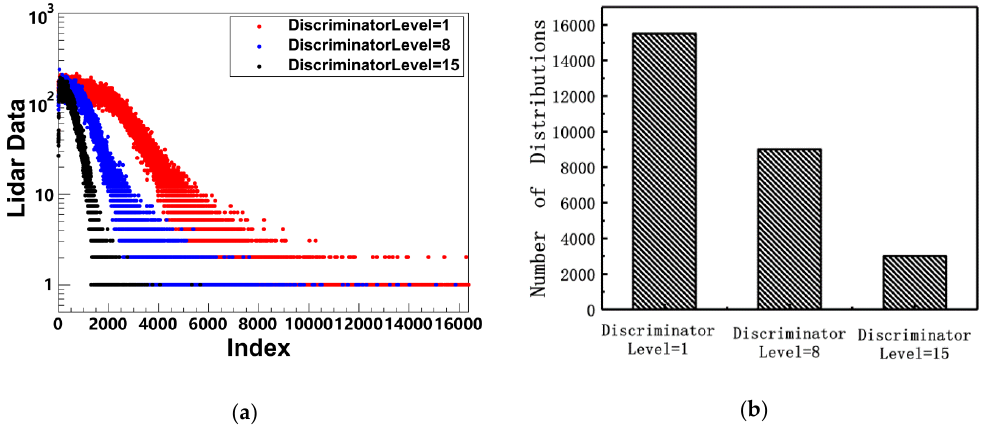
Figure 7. ( a ) Probing profiles of photon-counting data with different settings of threshold voltage at the same atmospheric conditions and ( b ) their corresponding statistics of the non-zero distributions.